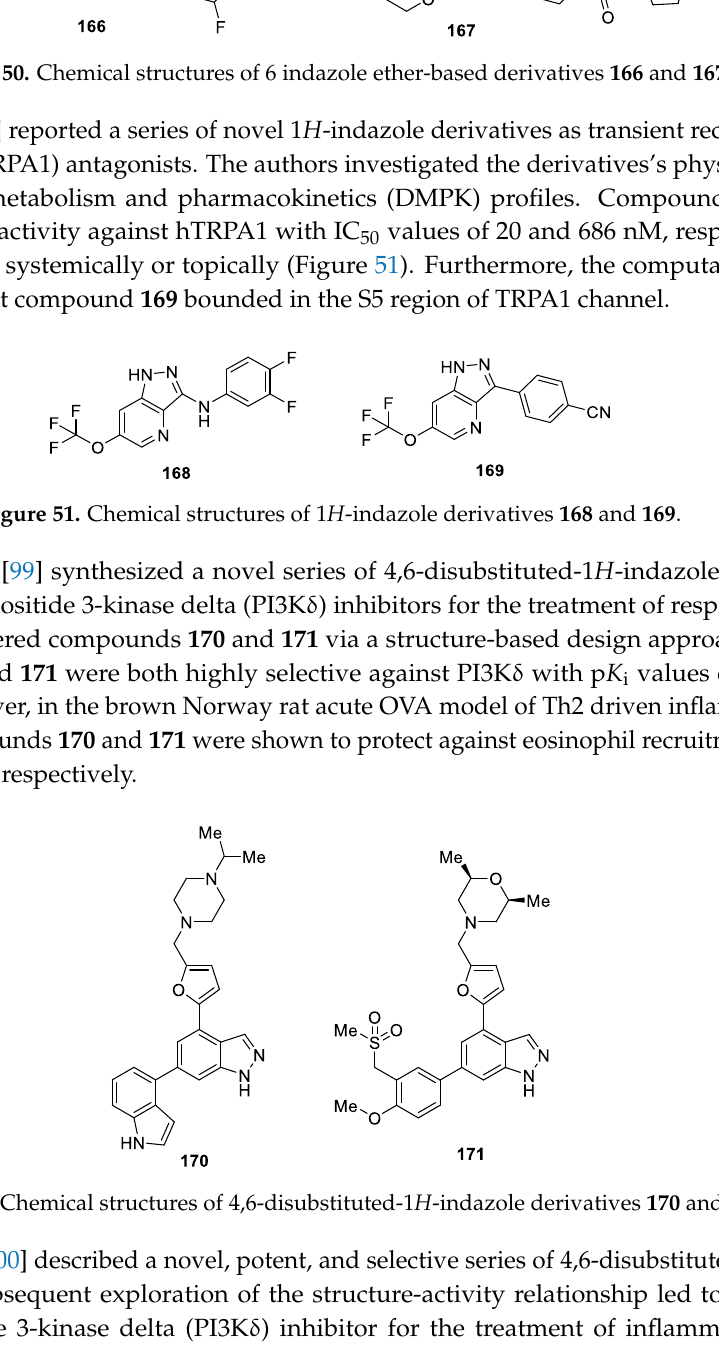
Figure 53. Chemical structure of 4,6-disubstituted-1 H -indazole derivative 172. Ellman et al. [101] prepared and evaluated a novel series of N -alkylated indazole chloroacetamidine derivatives as potential protein arginine deiminase 4 (PAD4) inhibitors. Derivatization around the indazole ring with chloro substituents then led to the identification of trichloroindazole compound 173 with high inhibitory activity against PDAs ( k inact / K I values: PDA1, 20 ± 5; PAD2, 940 ± 240; PAD3, 5100 ± 400, 5,4000 ± 3000) (Figure 54). Furthermore, compound 173 inhibited PAD4-mediated H4 citrullination at low micromole concentrations. Figure 54. Chemical structure of N-alkylated-1 H -indazole derivative 173. Ripa et al. [102] designed a novel series of 1 H -indazole derivatives as potent glucocorticoid receptor (GR) modulators and conducted transactivation (TA) and transrepression (TR) assays. Based on the assays results, the compounds were further evaluated in functional assays measuring inhibition of lipopolysaccharide (LPS) induced tumor necrosis factor (TNF) α release in whole blood, upregulation of tyrosine aminotransferase (TAT) in primary hepatocytes, and downregulation of osteoprotegerin (OPG) in human fetal osteoblasts (hFOB). The experimental data ultimately lead to the discovery of compound 174 , which displayed excellent inhibitory activity against GR with IC 50 value of 3.8 nM (Figure 55). In addition, compound 174 exhibited excellent efficacy in the streptococcal cell wall (SCW) reactivation model of joint inflammation.